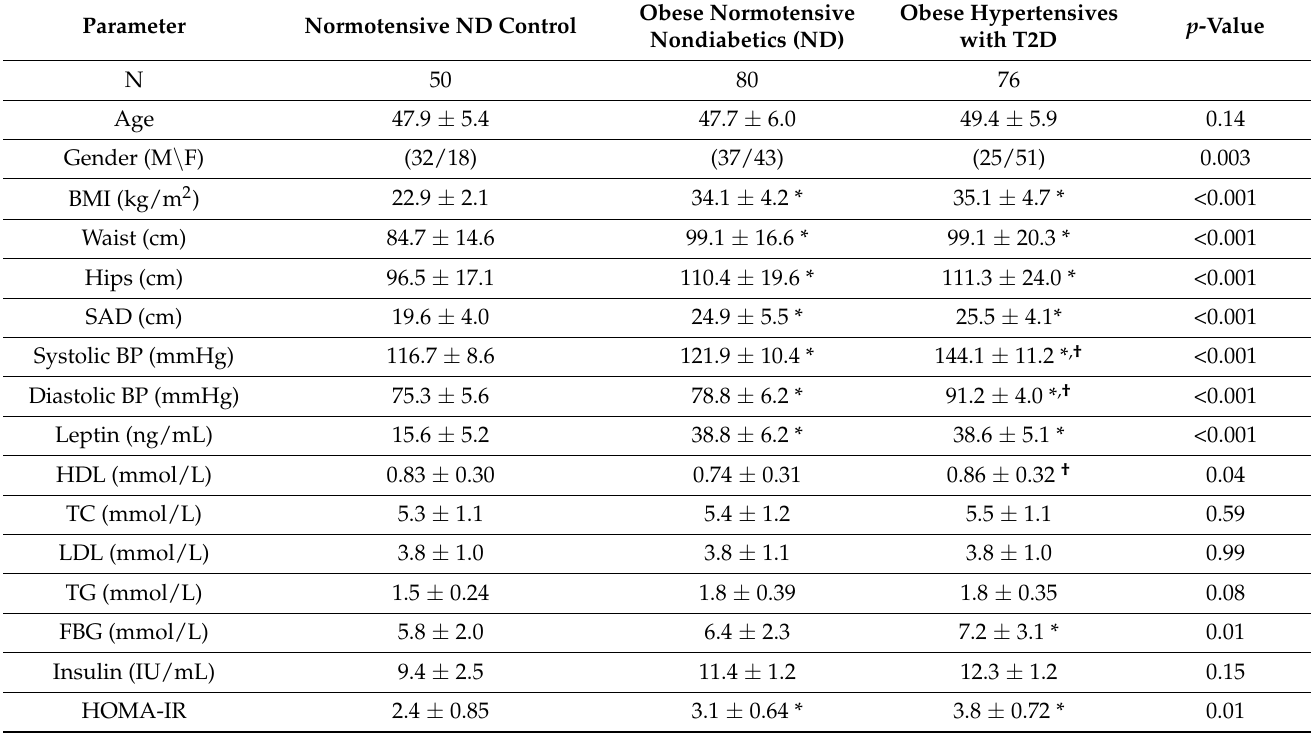
Table 1. Anthropometric and clinical characteristics of the study